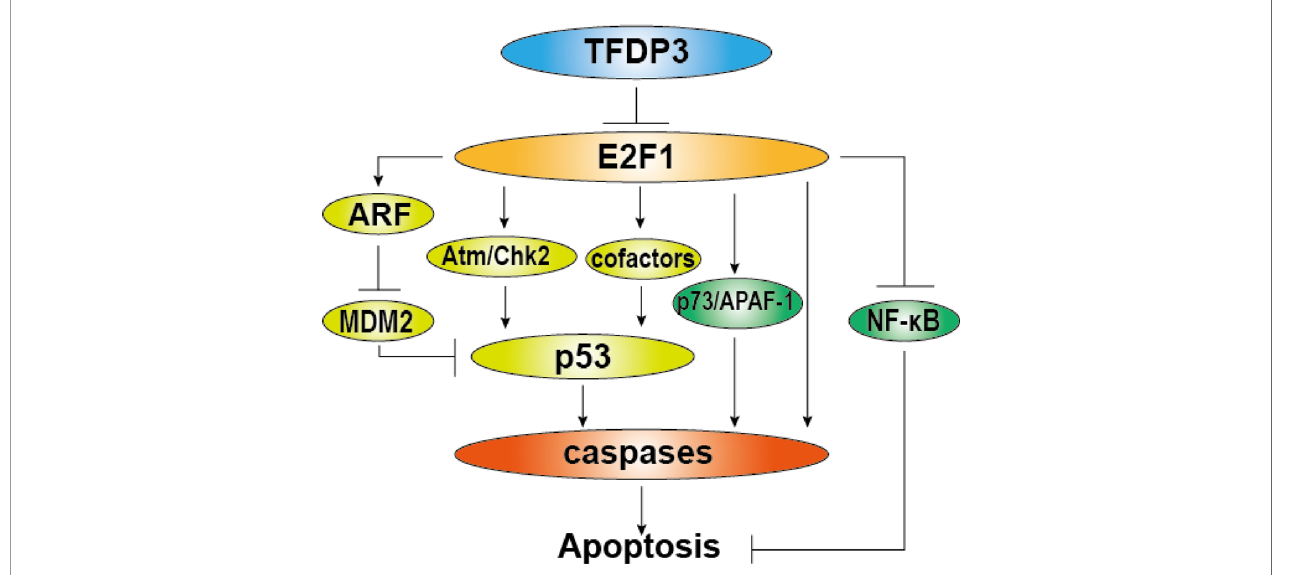
FIGURE 4 | Role of TFDP3 in E2F1-induced apoptosis. The diagram summarizes general activation pathways of E2F1-induced apoptosis and the repressive role of TFDP3. The light green part represents p53-dependent mechanisms, and the green part represents p53-independent mechanisms. In the present TFDP3, the effect of E2F1-induced apoptosis is